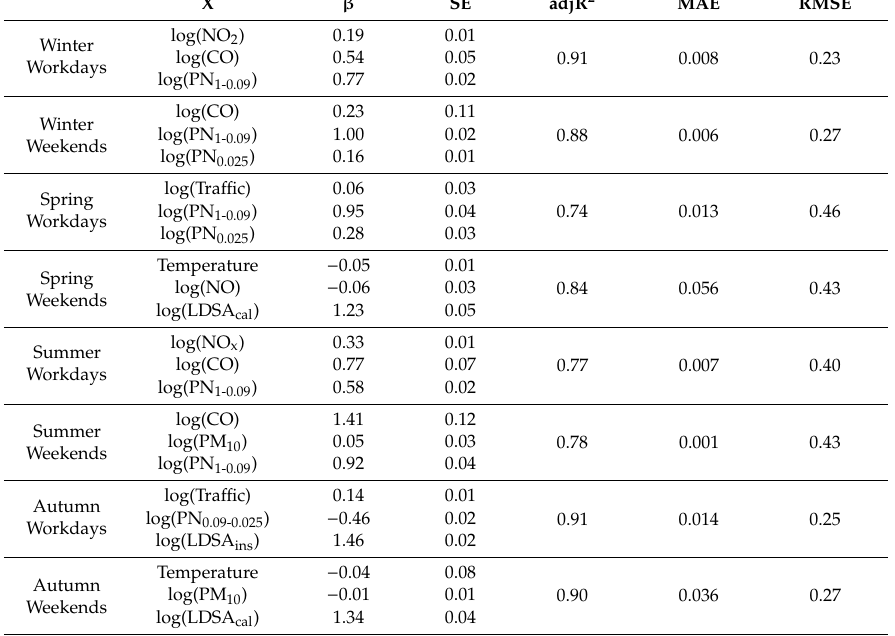
Table 5. Best performing OLS regression traditional proxy results in the street urban background in Kumpula (all models and all coe ffi cients of the corresponding input variables have p < 0.05). X represents the predictor variables in the di ff erent classes. β and SE are the coe ffi cients of the estimates and the corresponding standard errors, respectively. X β SE adjR